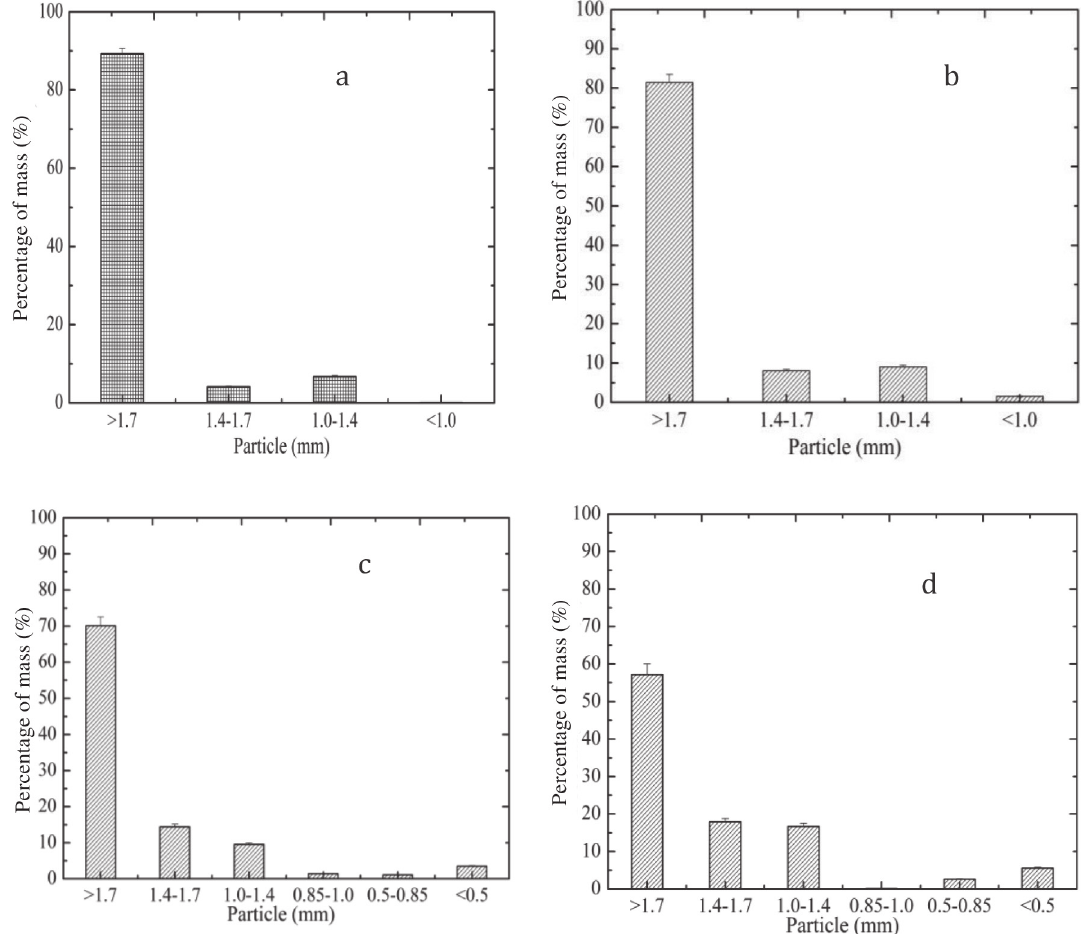
Fig. 1 – Particle size distribution of SNAGS after